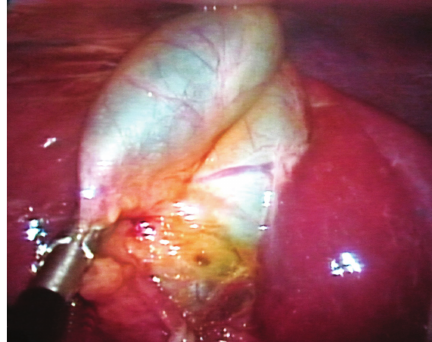
Figure 3: Laparoscopic image of duplicated gallbladder.